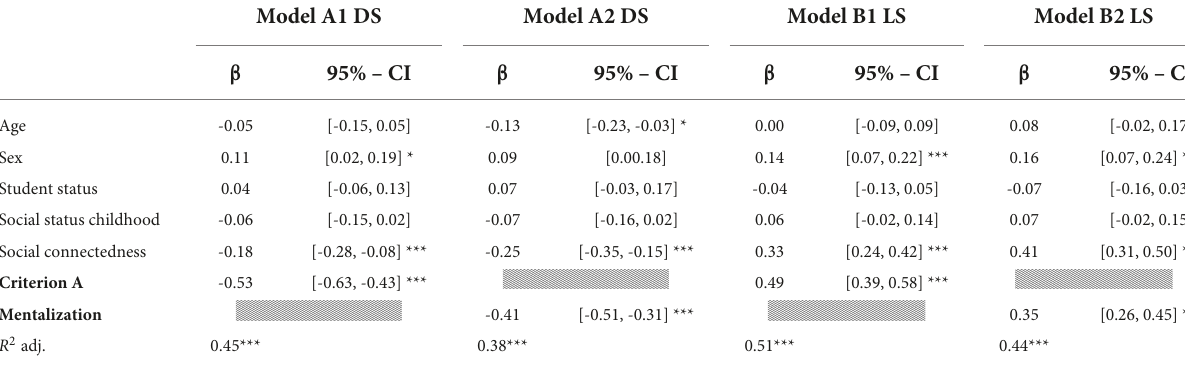
TABLE 2 Summary of linear regression analysis for variables predicting depressive symptoms and life satisfaction.